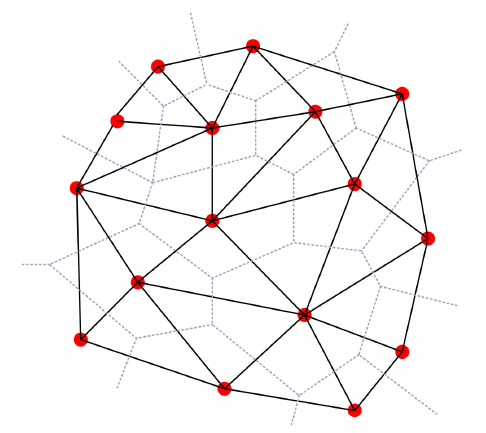
Figure 8. Delaunay triangulations and Voronoi diagrams for a set of 16 planar